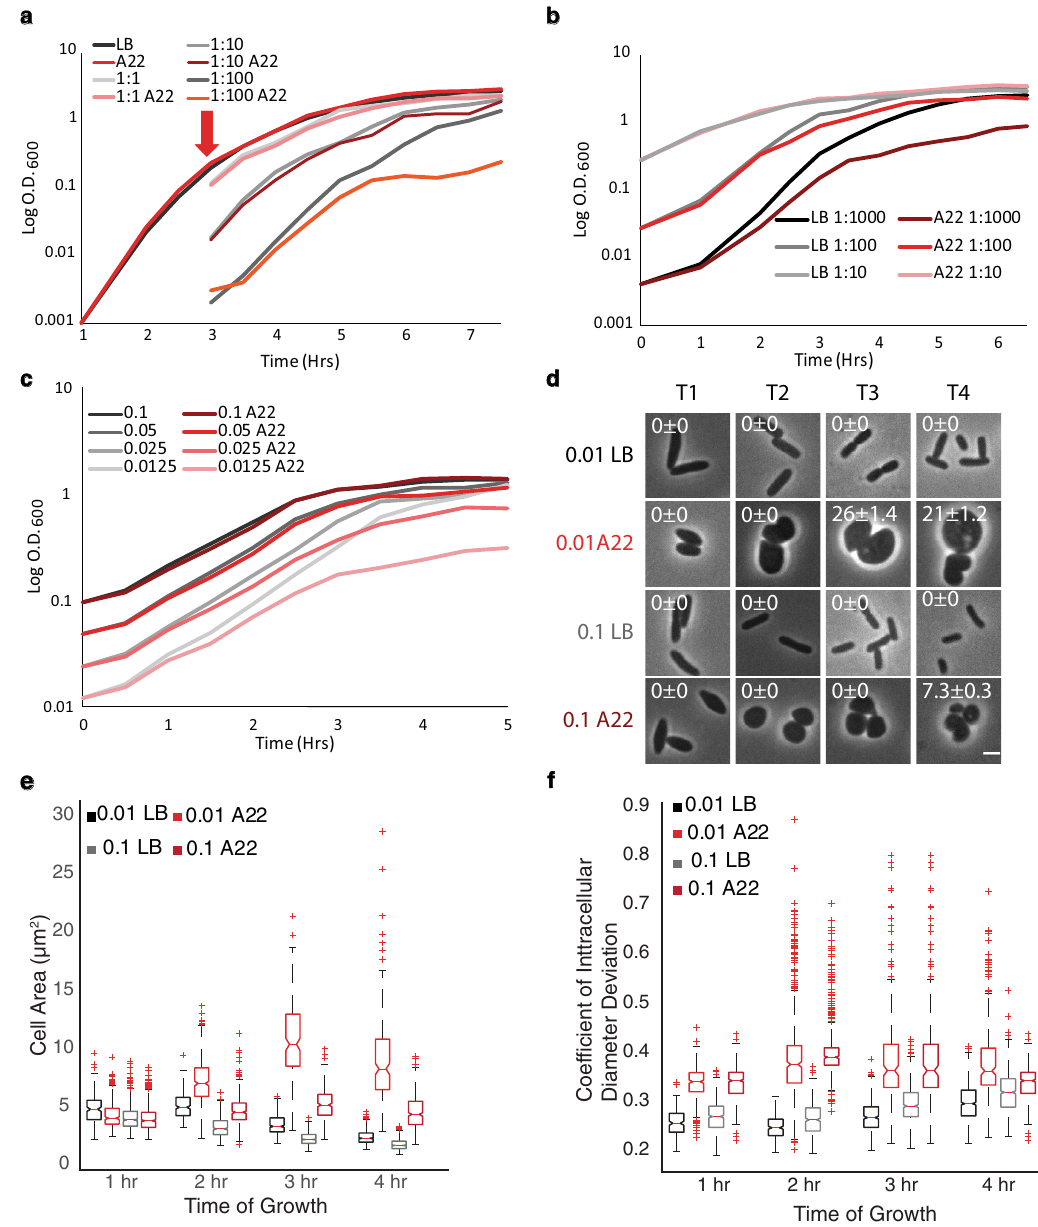
Fig. 2 Growth resistance is dependent on cell density. a Representative log-scale growth curve of WT cells grown at 37 °C treated with A22. Cells were grown in LB without A22 for three hours (arrow) and then either allowed to continue to grow, spiked with A22, or back diluted into pre-warmed media with and without A22 (10 μ g/ml) at the indicated dilution factors. b Representative log-scale growth curve of WT cells grown at 37 °C with different inoculation dilutions. Cells were grown with and without A22 (10 μ g/ml) in LB at the indicated initial inoculation ratio from overnight cells. c Representative log-scale growth curve of wild-type cells with different starting ODs. Overnight cells were washed and resuspended into new MOPS media and inoculated at the indicated OD 600 with and without A22 (10 μ g/ml). Growth rates for each starting OD can be found in Table S3. d Representative phase-contrast images of WT cells grown at 37 °C from OD 600 ~0.01 or 0.1 with and without A22 (10 μ g/ml). Cells were imaged every hour for 4 h. White arrow indicates cell vesicles forming in advance of lysis and numbers in the upper left represent the percentage of cells displaying vesicles and the Poisson error to one standard deviation. The growth curve can be found in Fig. S3d. The scale bar is equal to 2 µ m. e , f Quanti fi cation of cells imaged in d . Red pluses are outliers, the red line is the median, the bottom and top edges of the box represent 25th and 75th percentiles, respectively, and notches are 95% CI. Data were pooled from three independent experiments. e Cell area from cell imaging in d . f Coef fi cient of intracellular diameter deviation from cell imaging in d . e , f Number of cells can be found in Table